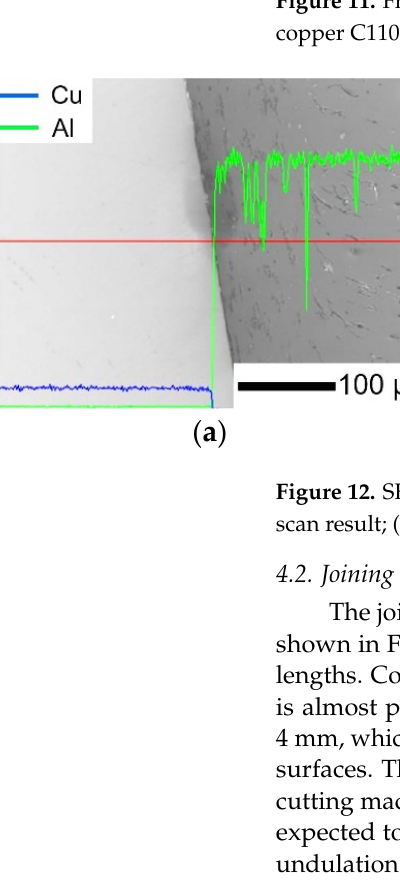
Figure 13. Joined specimen using shaved face (left: C1100, right: A6061, shaving allowance: C1100 1.0 mm, A6061 0.9 mm, overlap length: 0.1 mm).